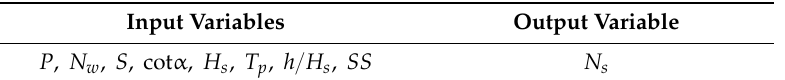
Table 2. Input and output